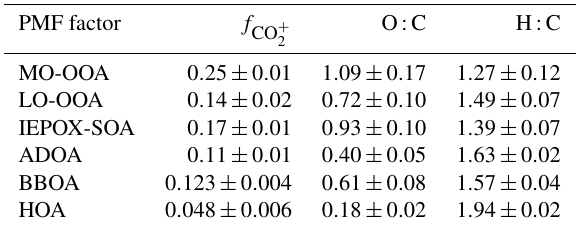
Table 1. Characteristics of the PMF factors derived from the AMS datasets. Listed are signal fractions f at nominal m/z 44 and CO + 2 oxygen-to-carbon (O:C) and hydrogen-to-carbon (H:C) ratios. Values and associated uncertainties were calculated by running PMF in “bootstrap mode” (Ulbrich et al., 2009b). Elemental ratios were calibrated by the “improved-ambient” method, which has an estimated uncertainty of 12% for O:C and 4% for H:C (Cana- garatna et al., 2015). O:C PMF factor f CO + 2